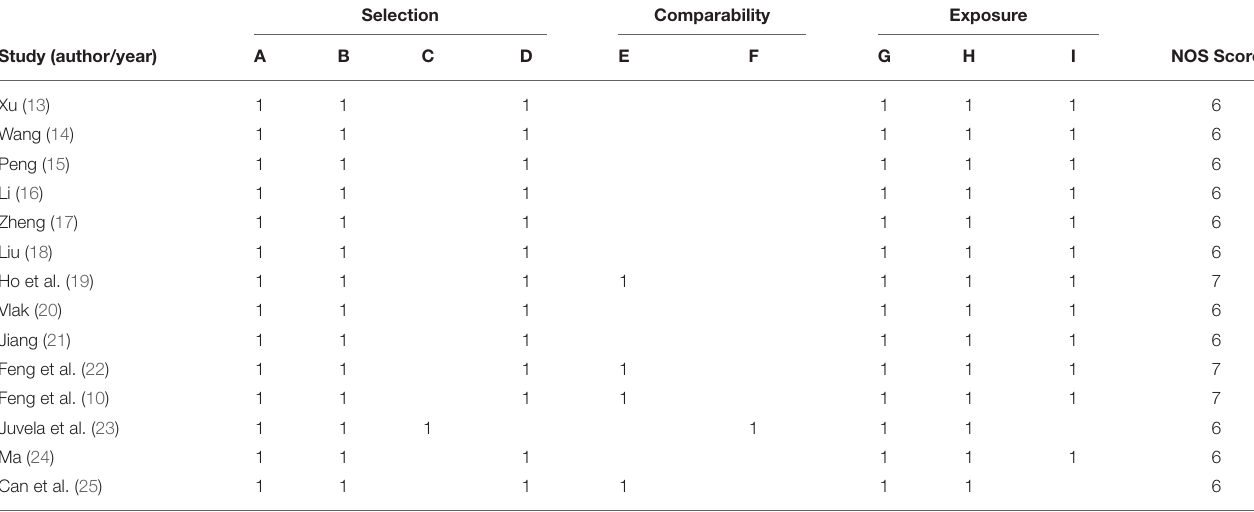
TABLE 2 | NOS scores for included studies.